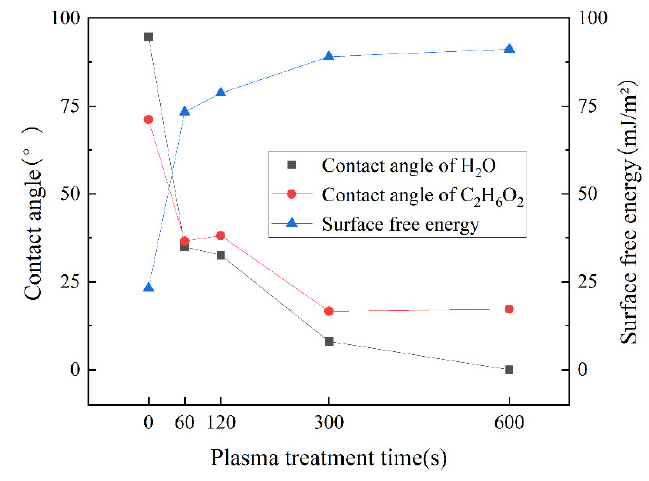
Figure 14. Effect of plasma treatment time on surface contact angle and surface free energy of CF/EP.